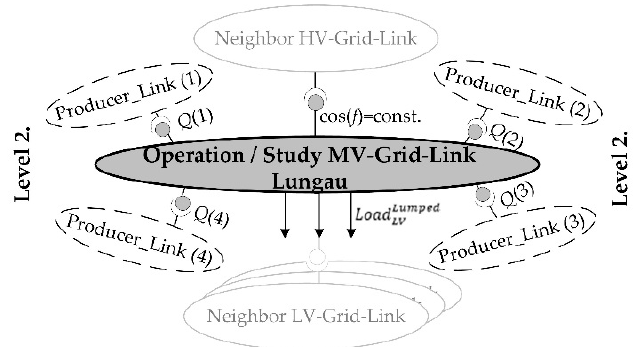
Figure 18. The implemented technical/functional LINK -based architecture in the ZUQDE project.